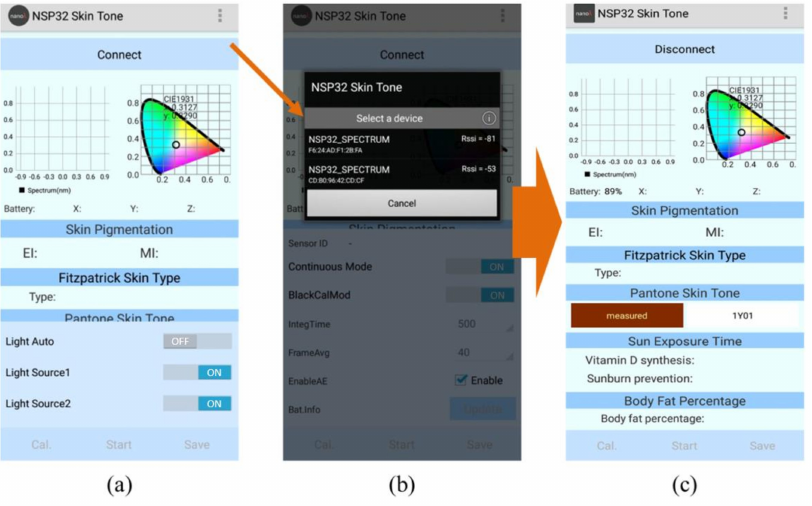
Figure 10. The operation process of app connection: ( a ) UI initial, ( b ) connection device, and ( c ) device connected and ready to use.